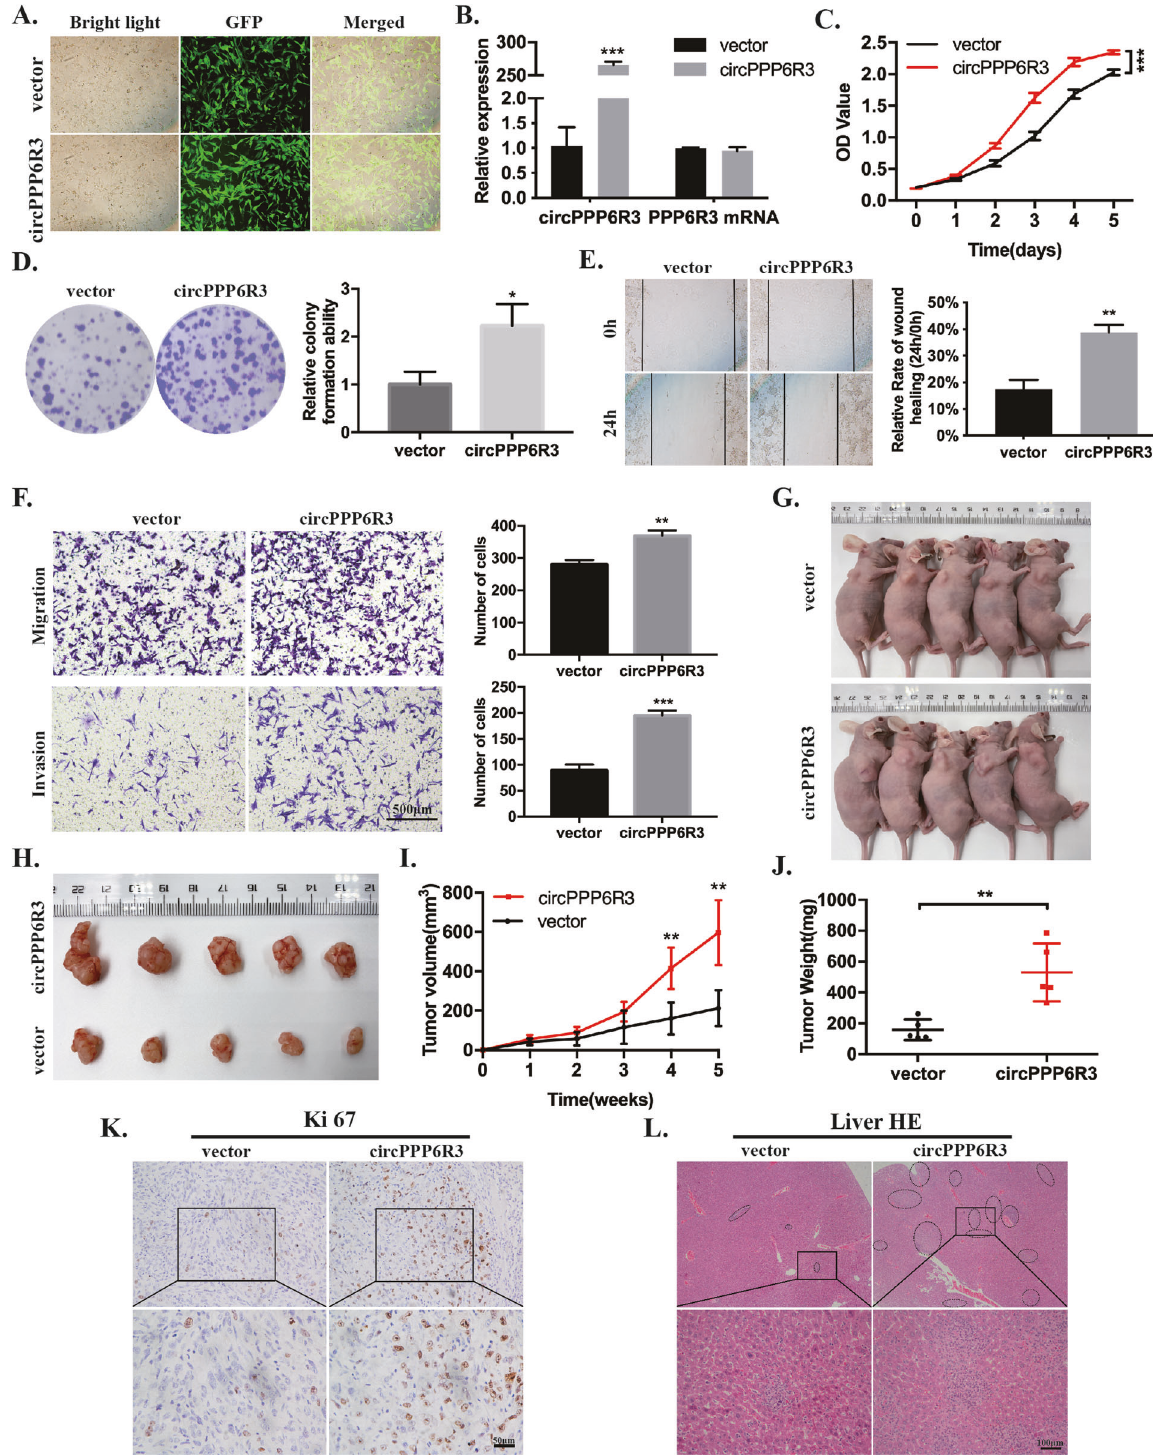
Fig. 3 Overexpression of circPPP6R3 promoted the progression of ccRCC. A Representative images were shown to exhibit the transfected effects of Caki-1 cells with the vector or circPPP6R3-overexpressing plasmids. B The overexpressing ef fi ciency of circPPP6R3 was detected in Caki-1 cells. C , D MTS assay and colony formation assay were performed to examine the proliferation of Caki-1 cells. E , F Transwell assay, invasion assay, and wound-healing assay were used to detect the migrative and invasive abilities of Caki-1 cells. G The images of the nude mice subcutaneously injected with the vector or circPPP6R3-overexpressed Caki-1 cells were shown. H The subcutaneous tumors of stably circPPP6R3-overexpressed or vector group were shown. I The growth curves of the subcutaneous tumors were performed by measuring the tumor volumes. J The weight of the subcutaneous tumors was measured. K Representative IHC images of the subcutaneous tumors stained with Ki67 in circPPP6R3-overexpressed or vector group were shown. L Representative HE images of the metastatic tumors in the liver in the hematogenous metastasis model were shown.